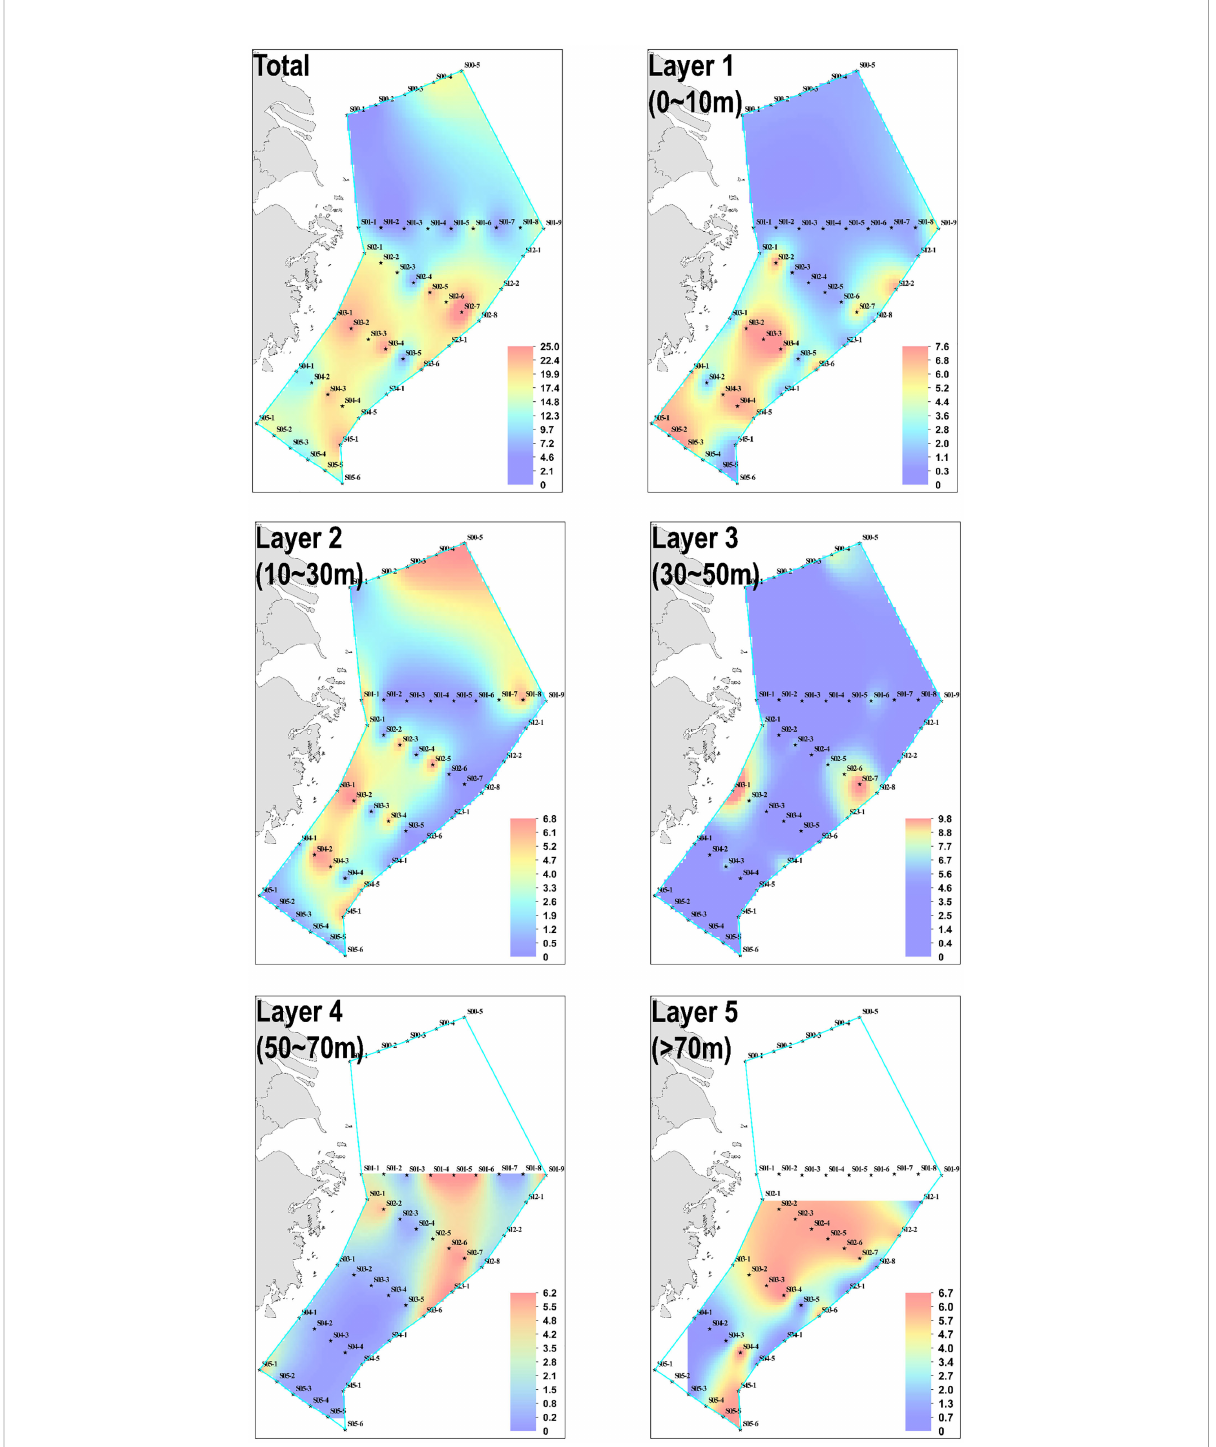
FIGURE 4 Horizontal distribution of P. echinogaster eDNA in the East China Sea. Layers 1 – 5 show the distribution of eDNA in different water layers, and the total is the sum of the eDNA concentrations of the fi ve water layers. Cool to warm colors represent low to high concentrations of